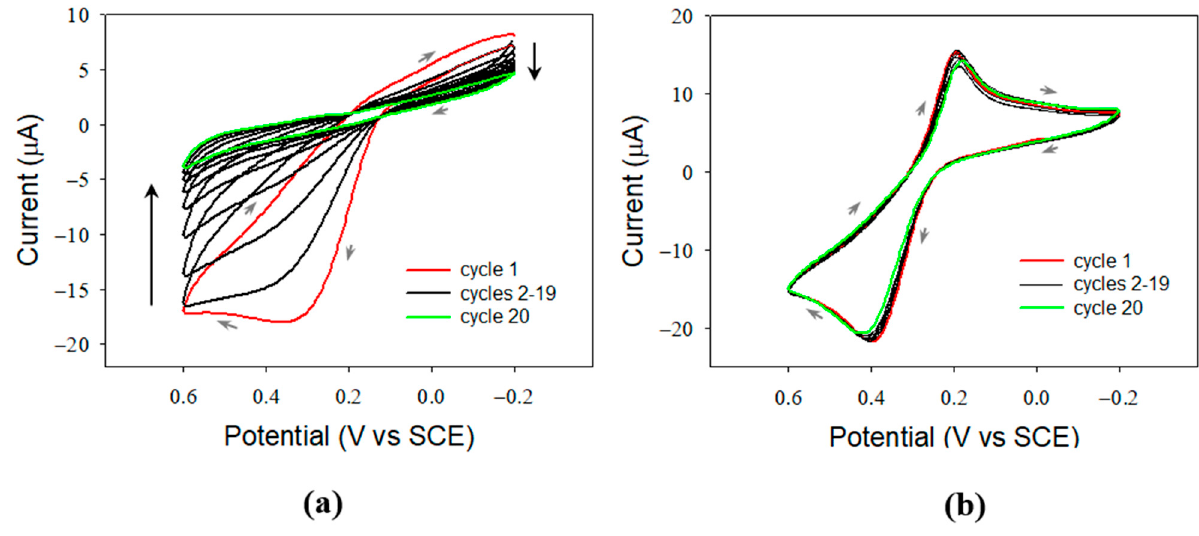
Figure 2. Cyclic voltammograms (20 cycles) relevant to dopamine 2.5 mM in phosphate buffer solution (I = 0.1 M, pH 7) ( a ) and in acetate buffer solution (I = 0.1 M, pH 5) ( b ) at a bare platinum electrode. Scan rate: 10 mV/s. The black arrows indicate the current evolution upon subsequent cycles, whereas the grey arrows indicate the scan